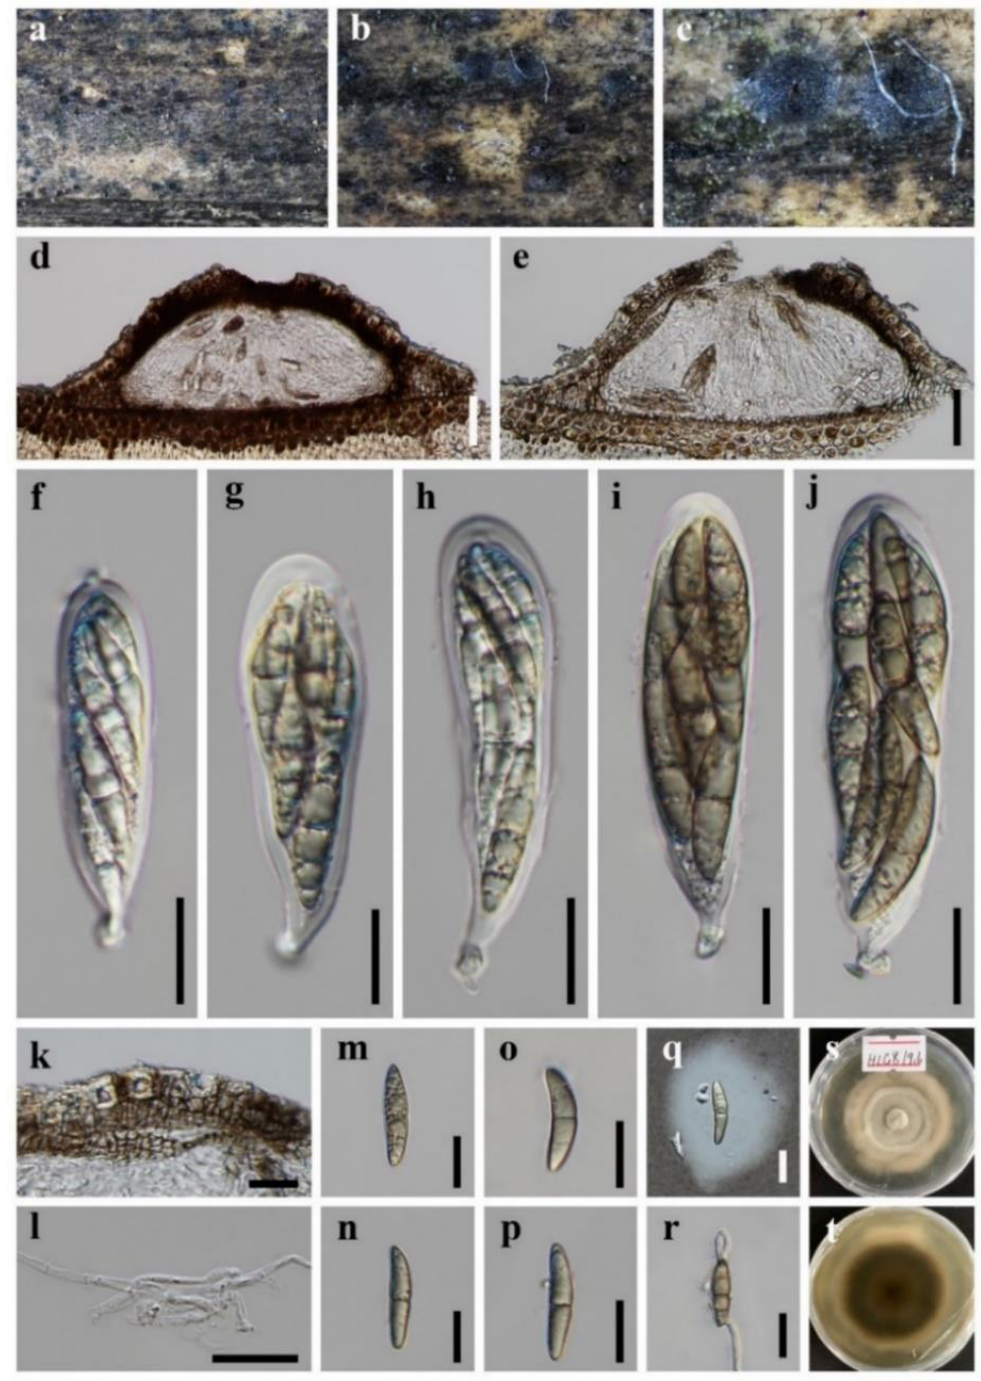
Figure 5. Occultibambusa sichuanensis (HKAS 123093, holotype ) ( a – c ) Ascomata on host substrate. ( d , e ) Vertical section of ascoma. ( f – j ) Asci. ( k ) Structure of peridium. ( l ) Pseudoparaphyses. ( s ) As- cospores. ( t ) Germinated ascospore. Colonies on PDA, above and below. Scale bars: ( d , e ) = 50 μm, ( f – k , m – t ) = 20 μm, ( l ) = 10 μm. MycoBank : MB 843720